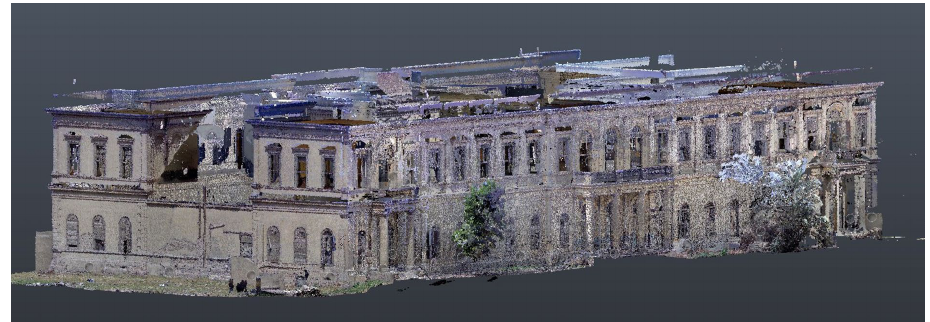
Figure 8. Tosson Palace point